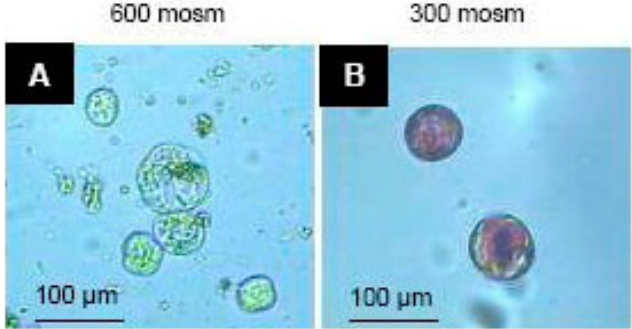
Fig. 5 - Protoplasts derived from six-day-old Cakile maritima cell sus-